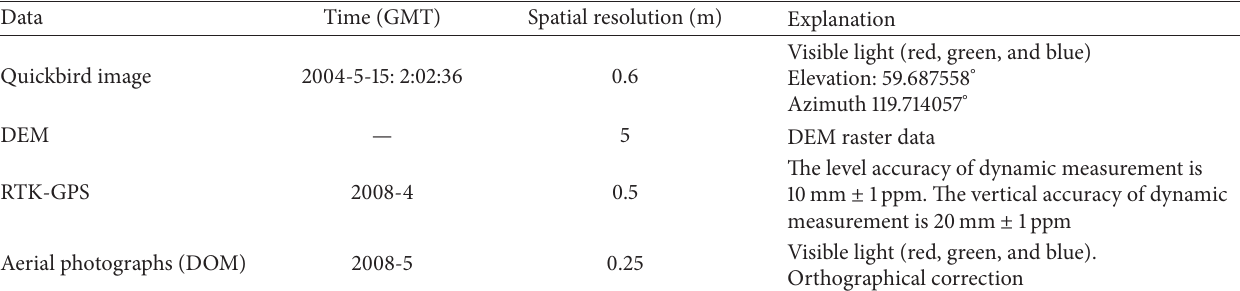
Table 1: Basic information of the experiment